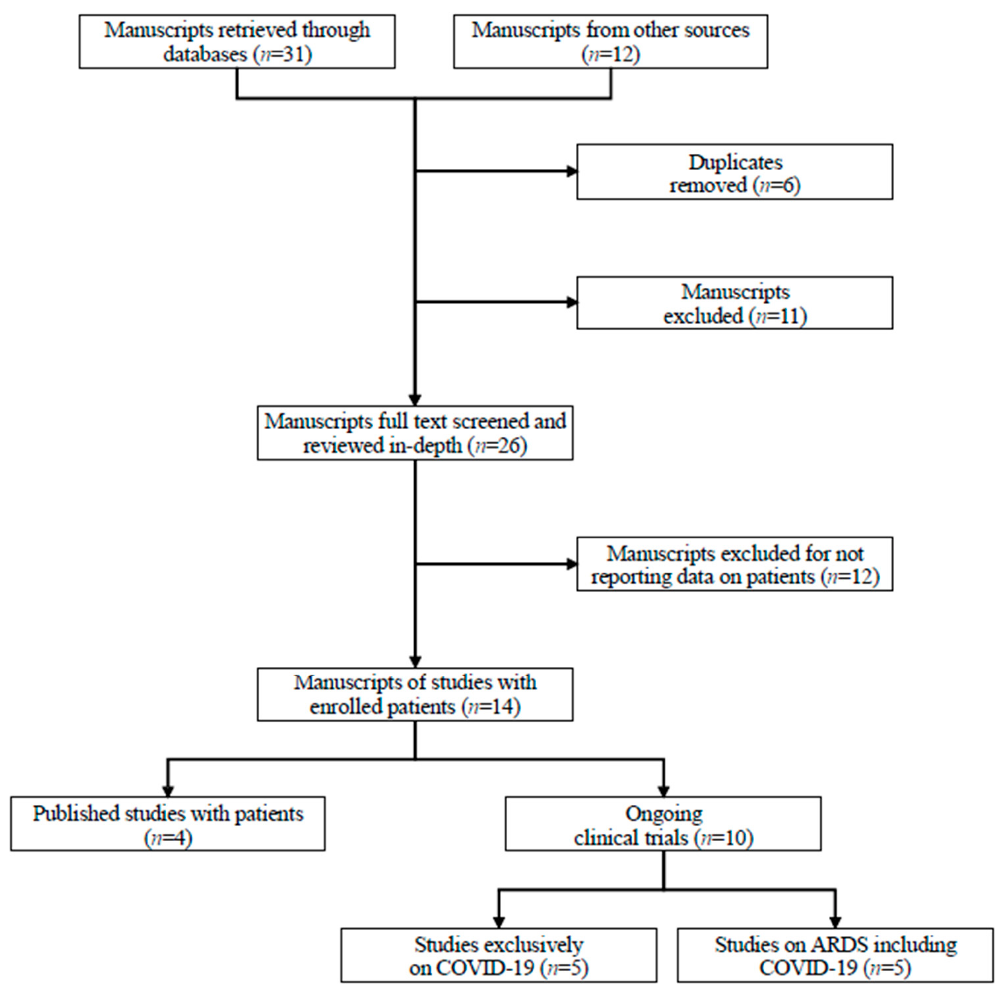
Figure 1. Selection of included studies.